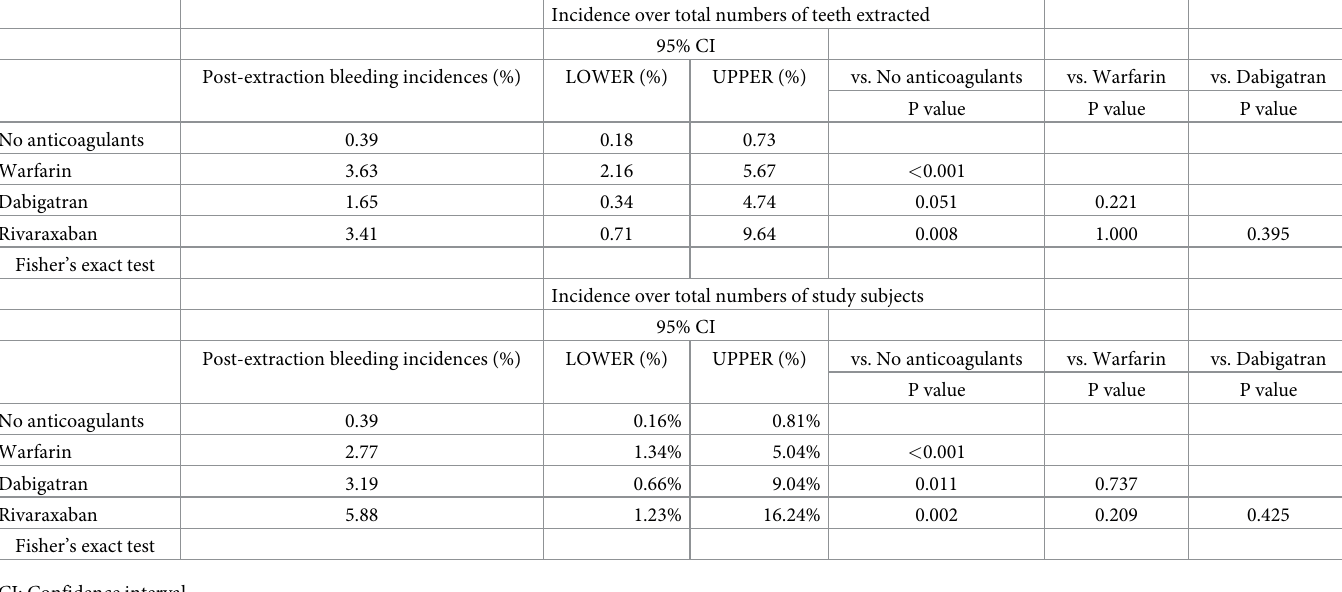
DOAC administration and tooth extraction times in subjects with In the dabigatran group, hemorrhage after extraction occurred in one subject treated between 9 am and 12 pm, in two subjects treated between 12 and 3 pm, and in no subjects treated Table 2. Incidences of clinically significant post-extraction bleeding and their difference. Incidence over total numbers of teeth extracted 95% CI Post-extraction bleeding incidences (%) LOWER (%)